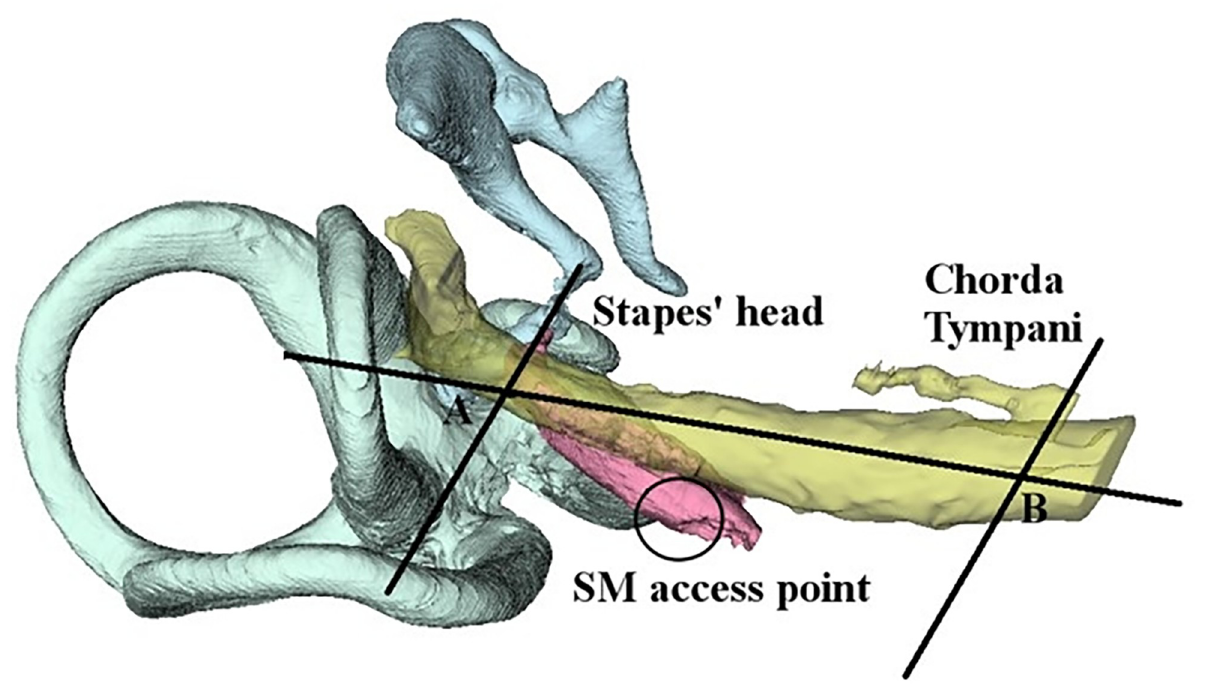
Fig 1. Schematic representation of the drilling spot identification to access the SM on the right side. A and B are the two extreme points of the segment running between the stapes’ head-tendon line (A) and the chorda tympani branching point (B), respectively. Adapted from [18].